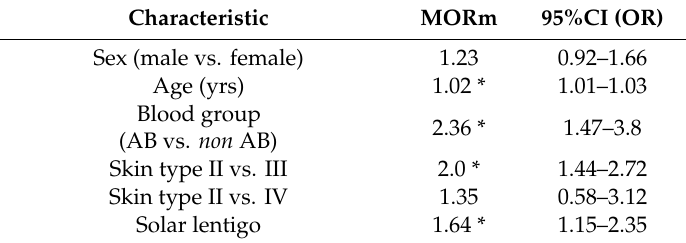
Table 3. Logistic model for nonmelanoma skin cancers